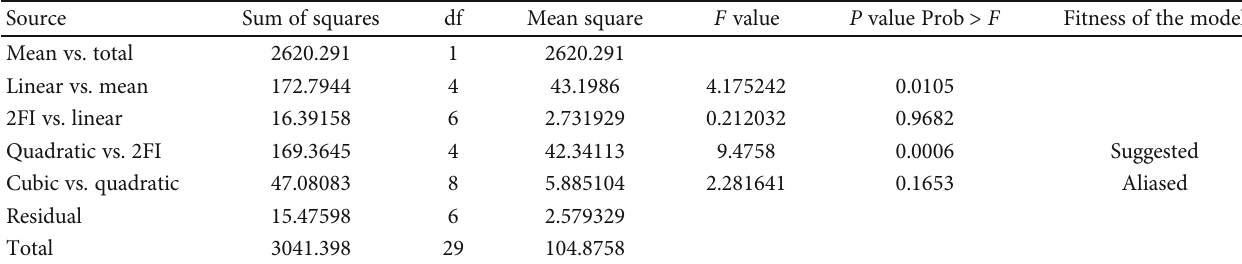
Table 3: Comparison of statistical models to choose the best RSM model for frost heaving force.